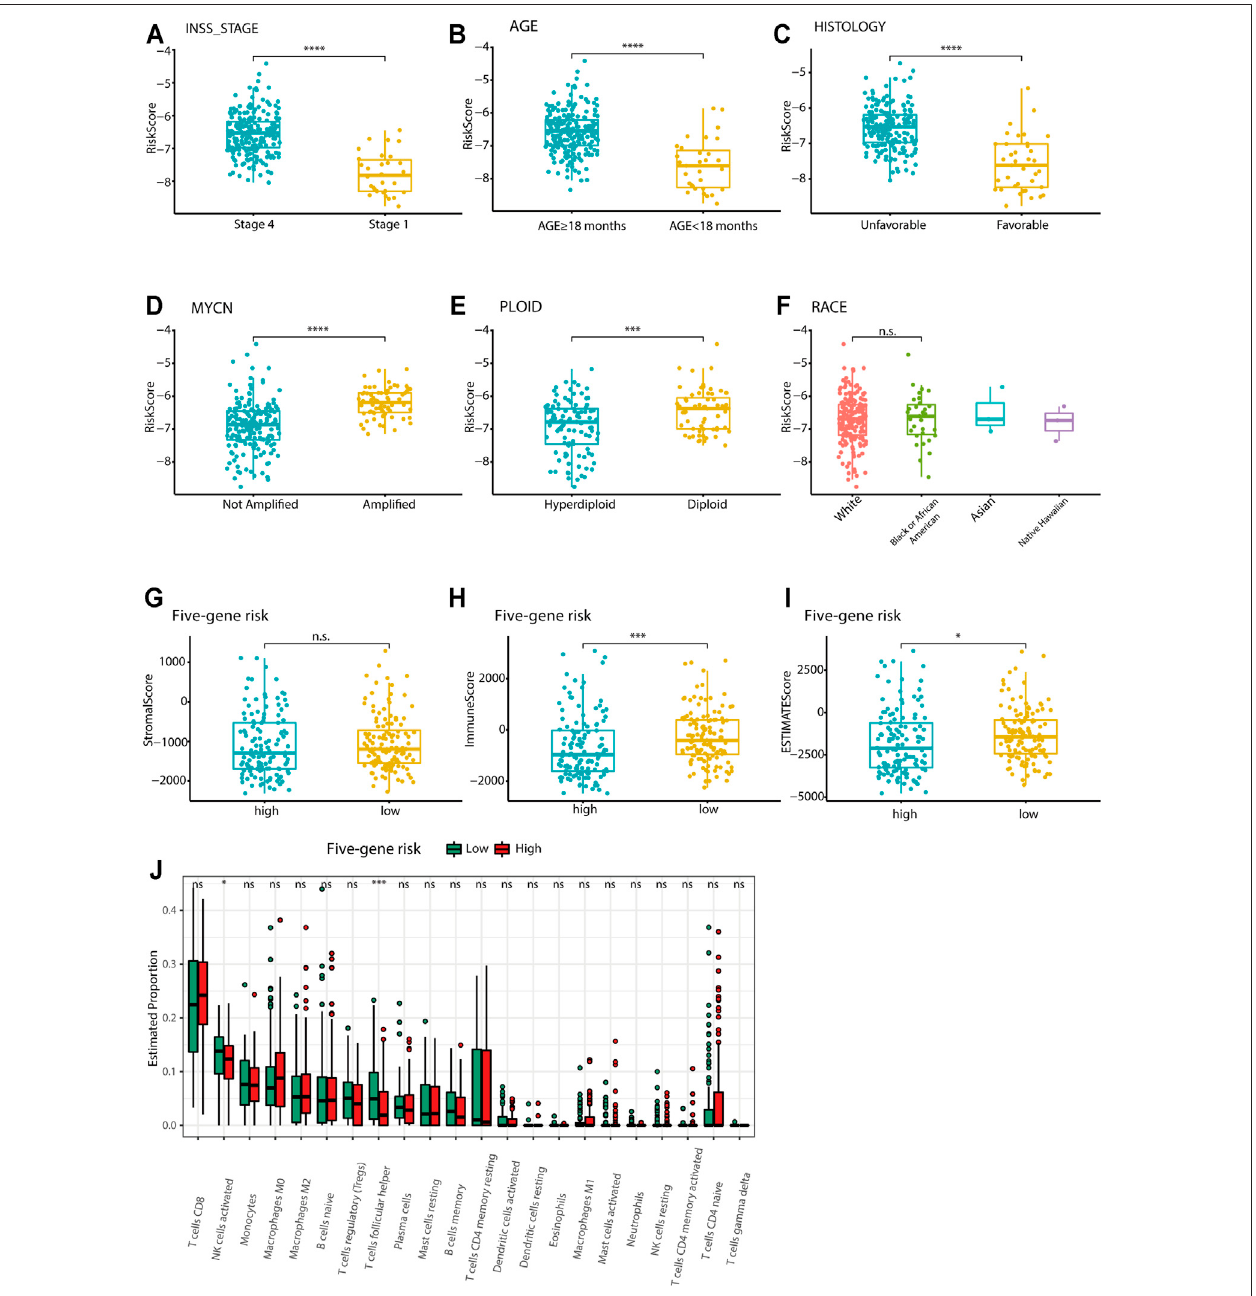
FIGURE 7 | Association of the fi ve-gene signature with clinicopathological parameters and tumor immune components. (A-F) Box plots of the distribution of the fi ve-gene risk score between different INSS stage groups (A) , between the age ≥ 18 months and age < 18 months groups (B) , between the favorable and unfavorable histology groups (C) , between the MYCN-ampli fi ed and MYCN-nonampli fi ed groups (D) , between the hyperdiploid and diploid groups (E) , and between different race groups (F) in the TARGET data set. *** p < 0.001, **** p < 0.0001, n. s. not signi fi cant, two-sided unpaired Wilcoxon test. (G-I) Box plots of the distribution of the stromalscore (G) ,immunescore (H) ,andestimatescore (I) calculatedbytheESTIMATEalgorithmbetweenthehigh-riskandlow-riskgroups.* p < 0.05,*** p < 0.001,n. s. not signi fi cant, two-sided unpaired Wilcoxon test. (J) Box plots of the distribution of the cell proportions calculated by the CIBERSORT algorithm of immune cells between the high-risk and low-risk groups. * p < 0.05, *** p < 0.001, n. s. not signi fi cant, two-sided unpaired Wilcoxon test.